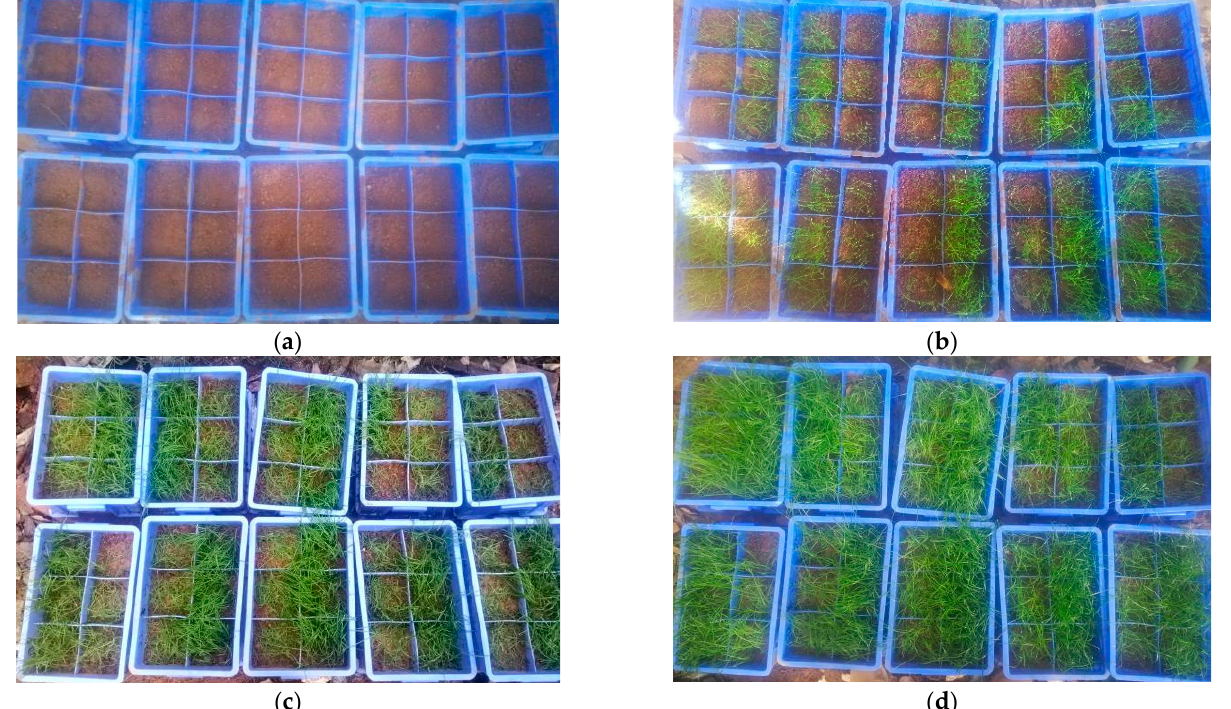
Figure 3. Actual effect pictures of adaptability investigation. ( a ) Ecological concrete covering soil with seeds; ( b ) sowing seeds for 10 days; ( c ) sowing seeds for 30 days; ( d ) sowing seeds for 60 days.